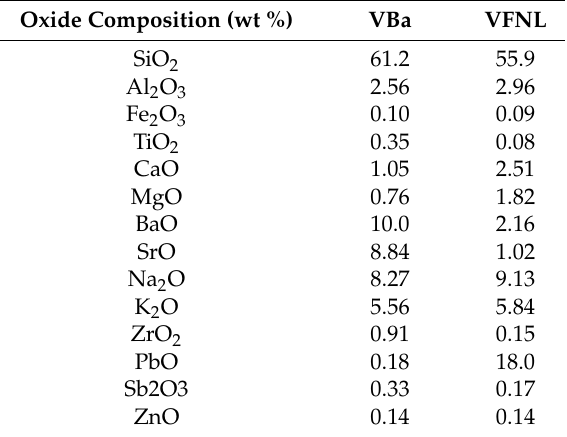
Table 1. Chemical analysis (Inductively coupled plasma atomic emission spectroscopy (ICP-AES)) expressed as wt % of glass rich in Ba and Sr (VBa) and funnel glass rich in Pb (VFNL) glasses. Oxide Composition (wt %) VBa